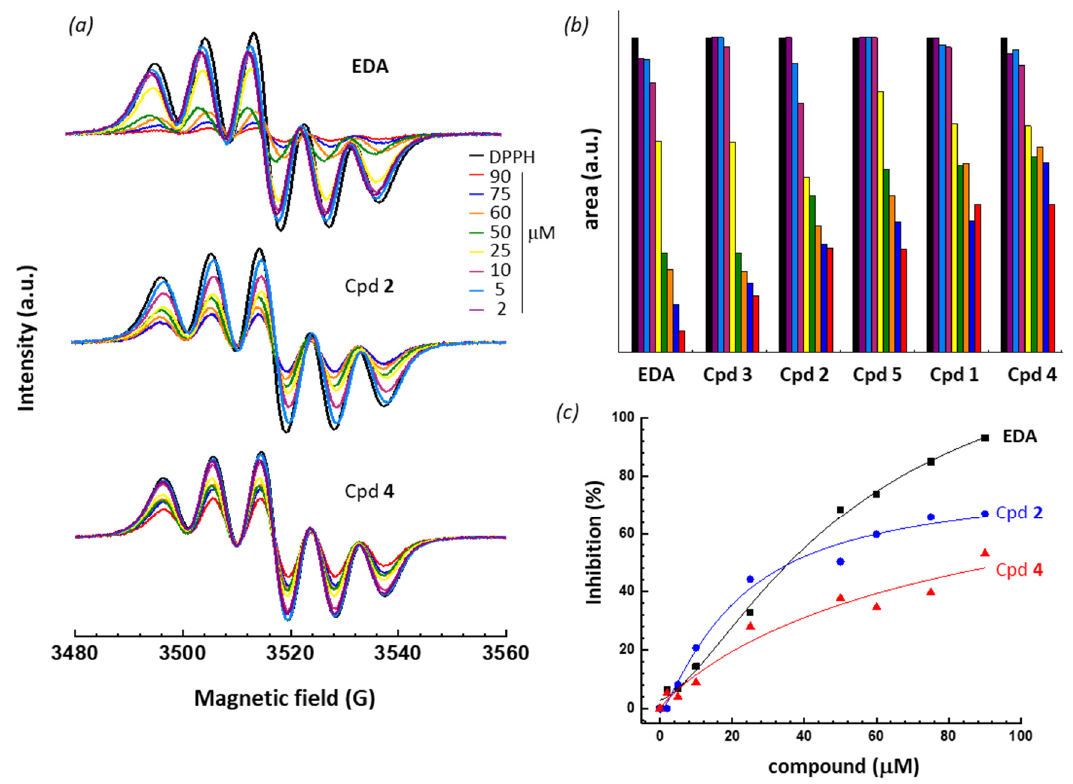
Figure 2. ( a ) EPR spectra of DPPH (100 µ M) in the presence of increasing amounts of the indicated compound. ( b ) Comparison of the DPPH radical scavenging activity of the compounds. DPPH was used at 100 μ M and the concentration of the test compound varied from 2 to 90 μ M, as indicated. ( c ) Dose-dependent antioxidant activities of compounds EDA, 2 and 4 . Inhibition (%) of the DPPH signal intensity as a function of the compound concentration. These plots were used to determine EC 50 values (Table 2). The color code is identical for panels 2a and 2b.